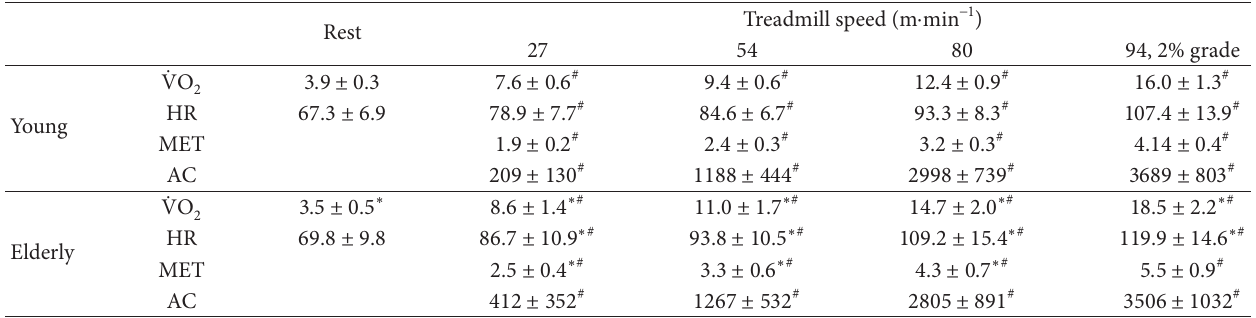
Table 3: Relative oxygen uptake (mL ⋅ kg ⋅ min − 1 ), heart rate, averaged activity counts, and measured MET values at rest and during treadmill walking in young ( 𝑛 = 16 ) and elderly subjects ( 𝑛 = 14 ).